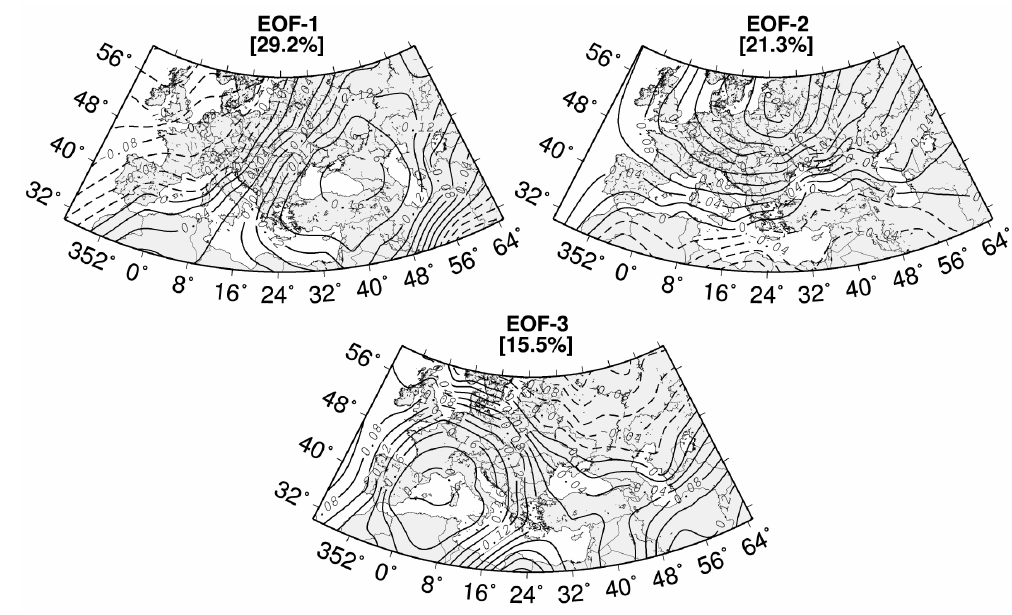
Fig. 6. Same as Fig. 5, but only for | NCPI | > 1 .